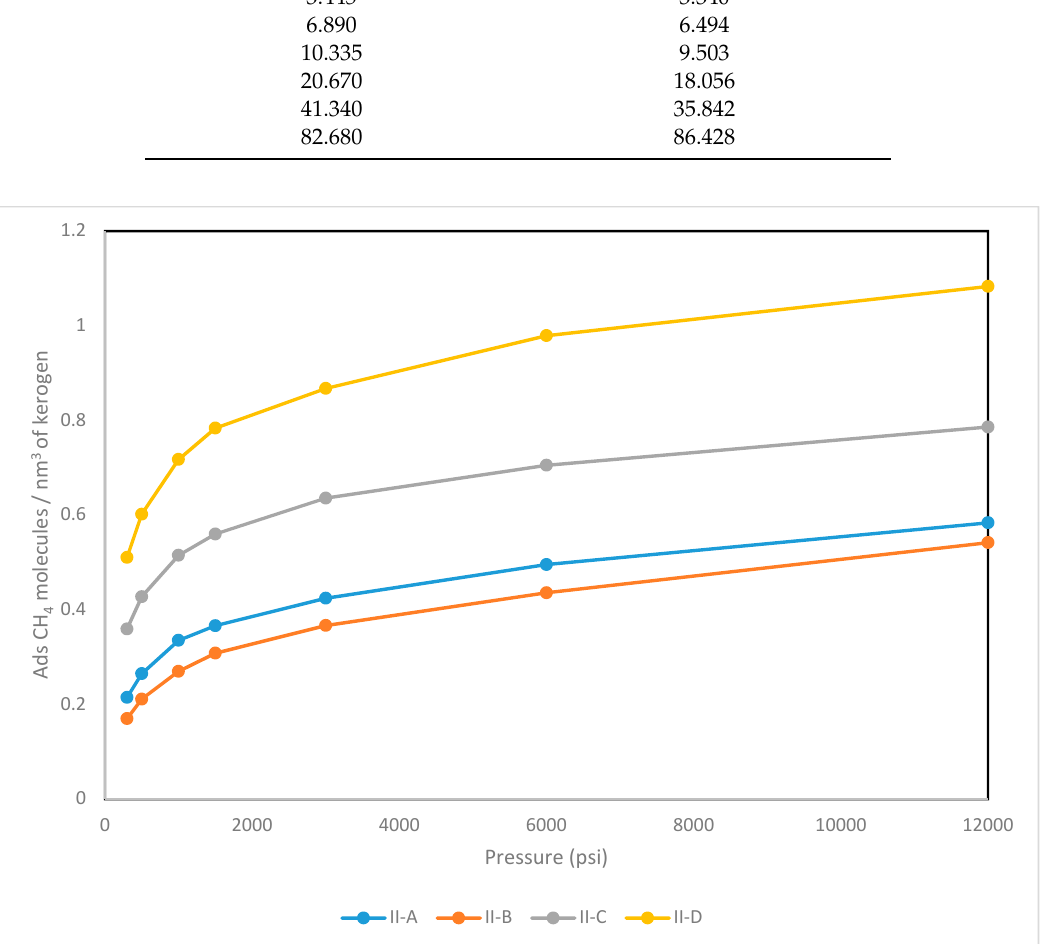
Figure 4. Adsorption profiles of methane for different types of kerogens.